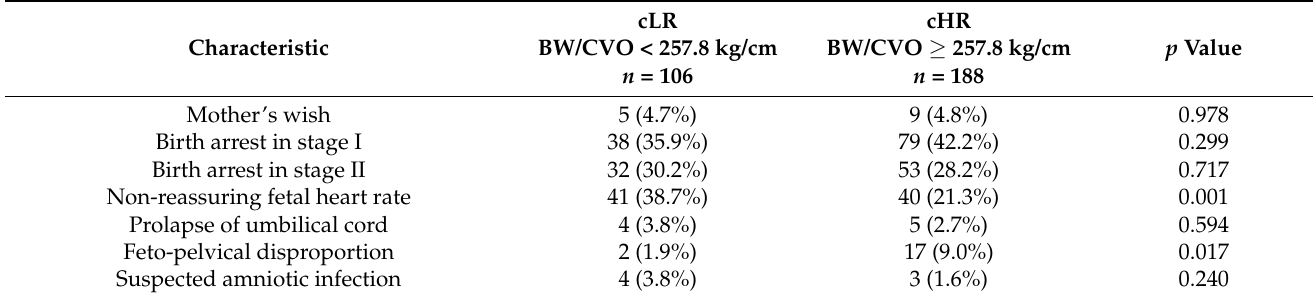
Table 3. Cesarean sections, indications ( n = 294).